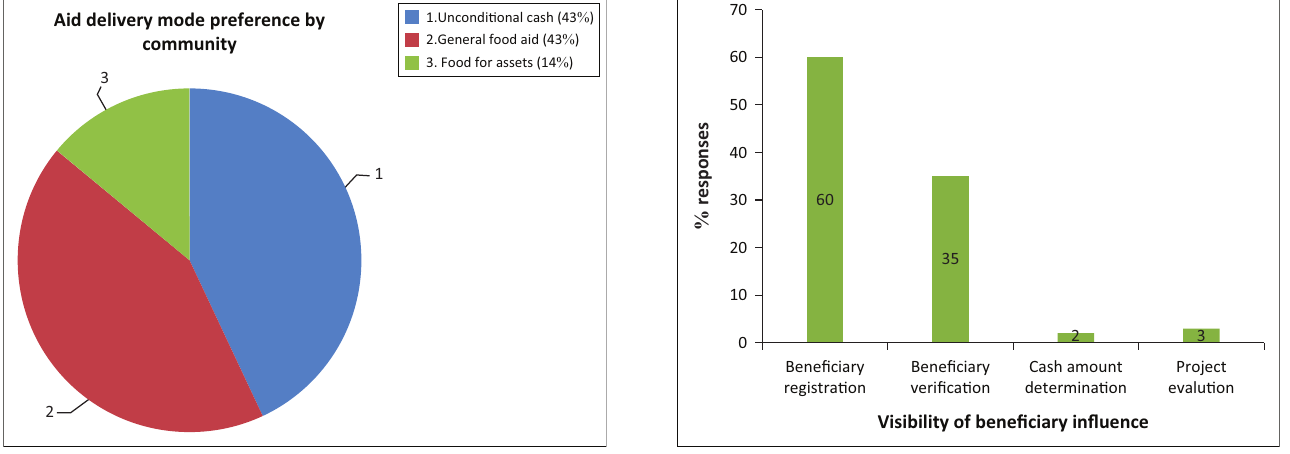
FIGURE 2: Community humanitarian distribution preferences. FIGURE 3: Recipients role in the